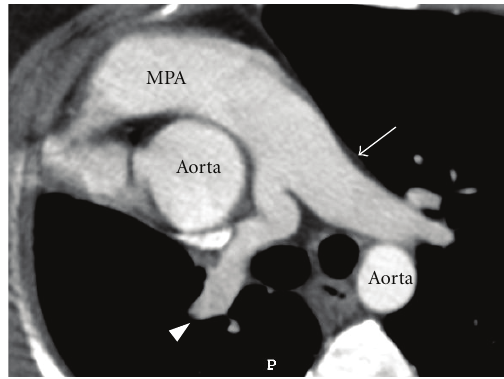
Figure 10: CT angiography axial image depicts contour abnormal- ity of right pulmonary artery (arrow head), Normal caliber left pulmonary artery (thin arrow), Main pulmonary artery (MPA).